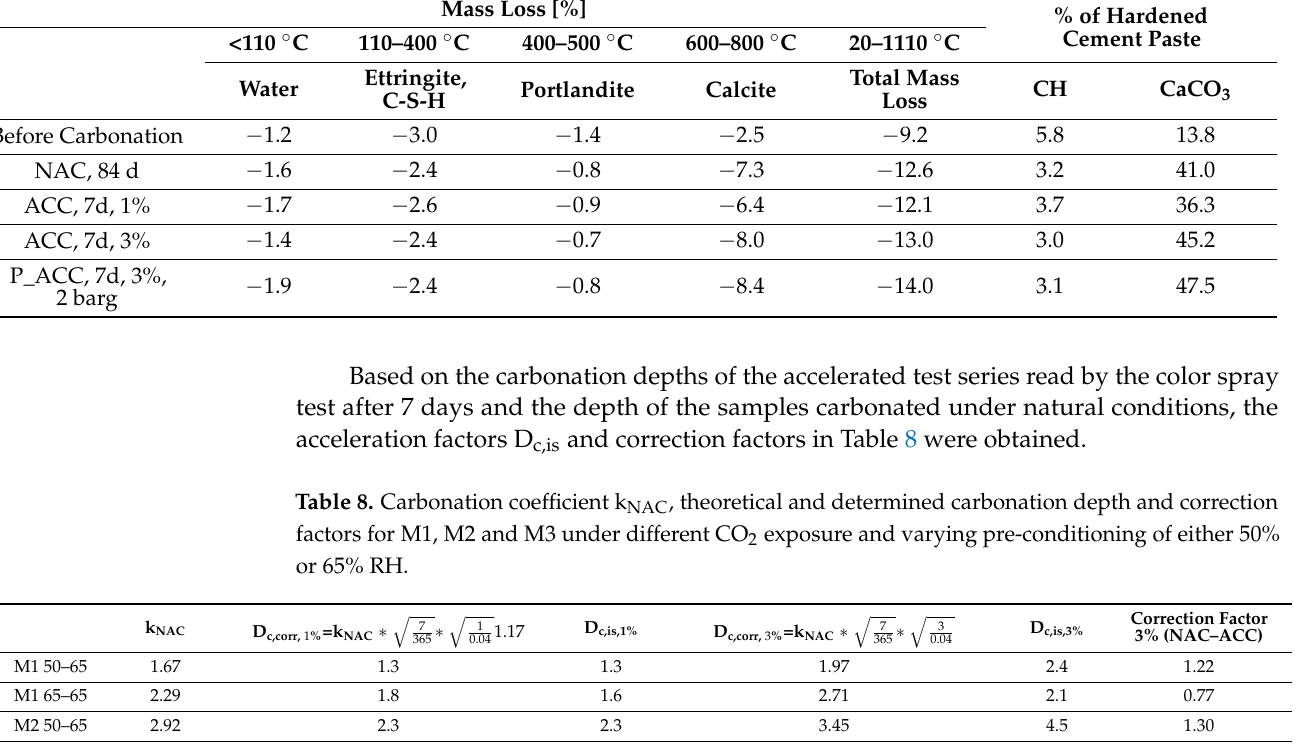
Table 7. Comparison of mass loss for natural (“NAC”, 0.04 vol.% CO 2 ), and accelerated carbonation (“ACC”, 1 vol.% CO 2 , 3 vol.% CO 2 and 3% plus 2 barg) at pre-storage at 65% RH; and 65% RH during carbonation. Mass Loss [%]